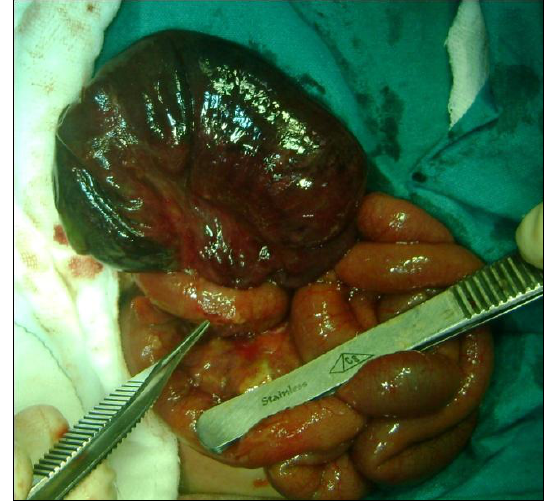
Figure 1: PSV in case 1.